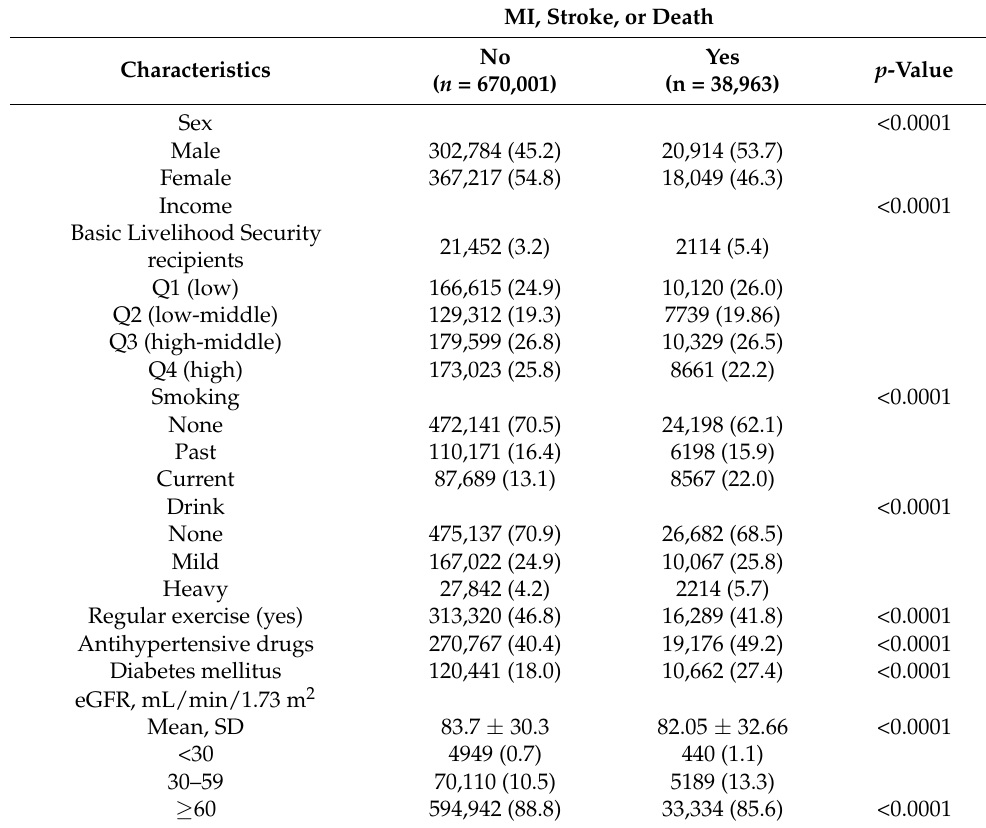
Table 1. Baseline characteristics of subjects with and without incident endpoints.